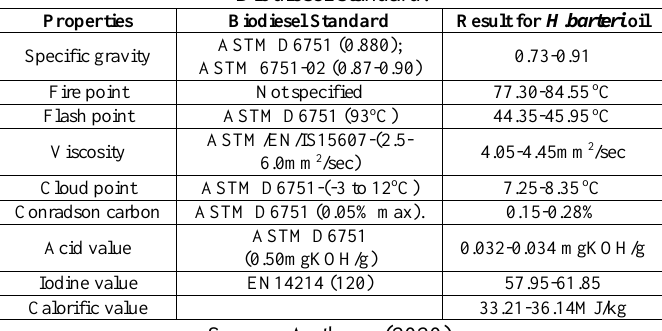
Table 4: Comparison of Physico-chemical properties with Biodiesel